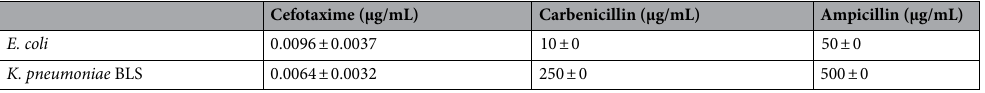
Table 3. Minimum inhibitory concentrations (MIC) of cefotaxime, carbenicillin, and ampicillin for E. coli and K. pneumoniae BLS. Values shown are mean ±